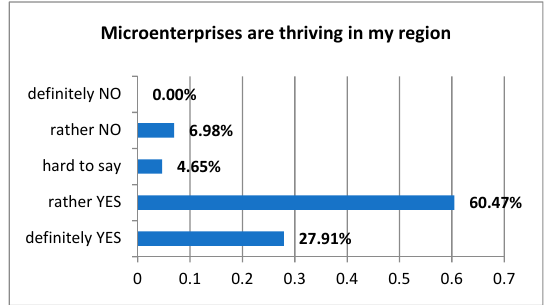
Figure 1. Most active entities in rural regions.